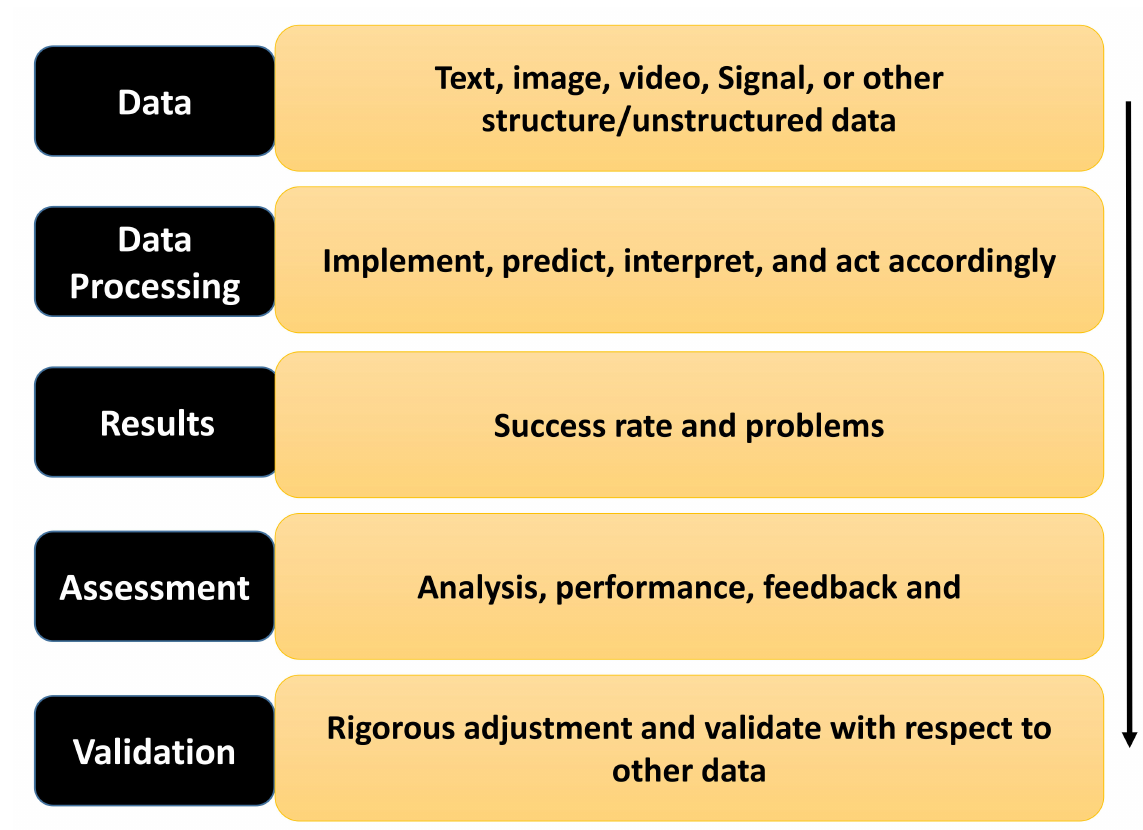
Figure 1. Working flow of SML process in